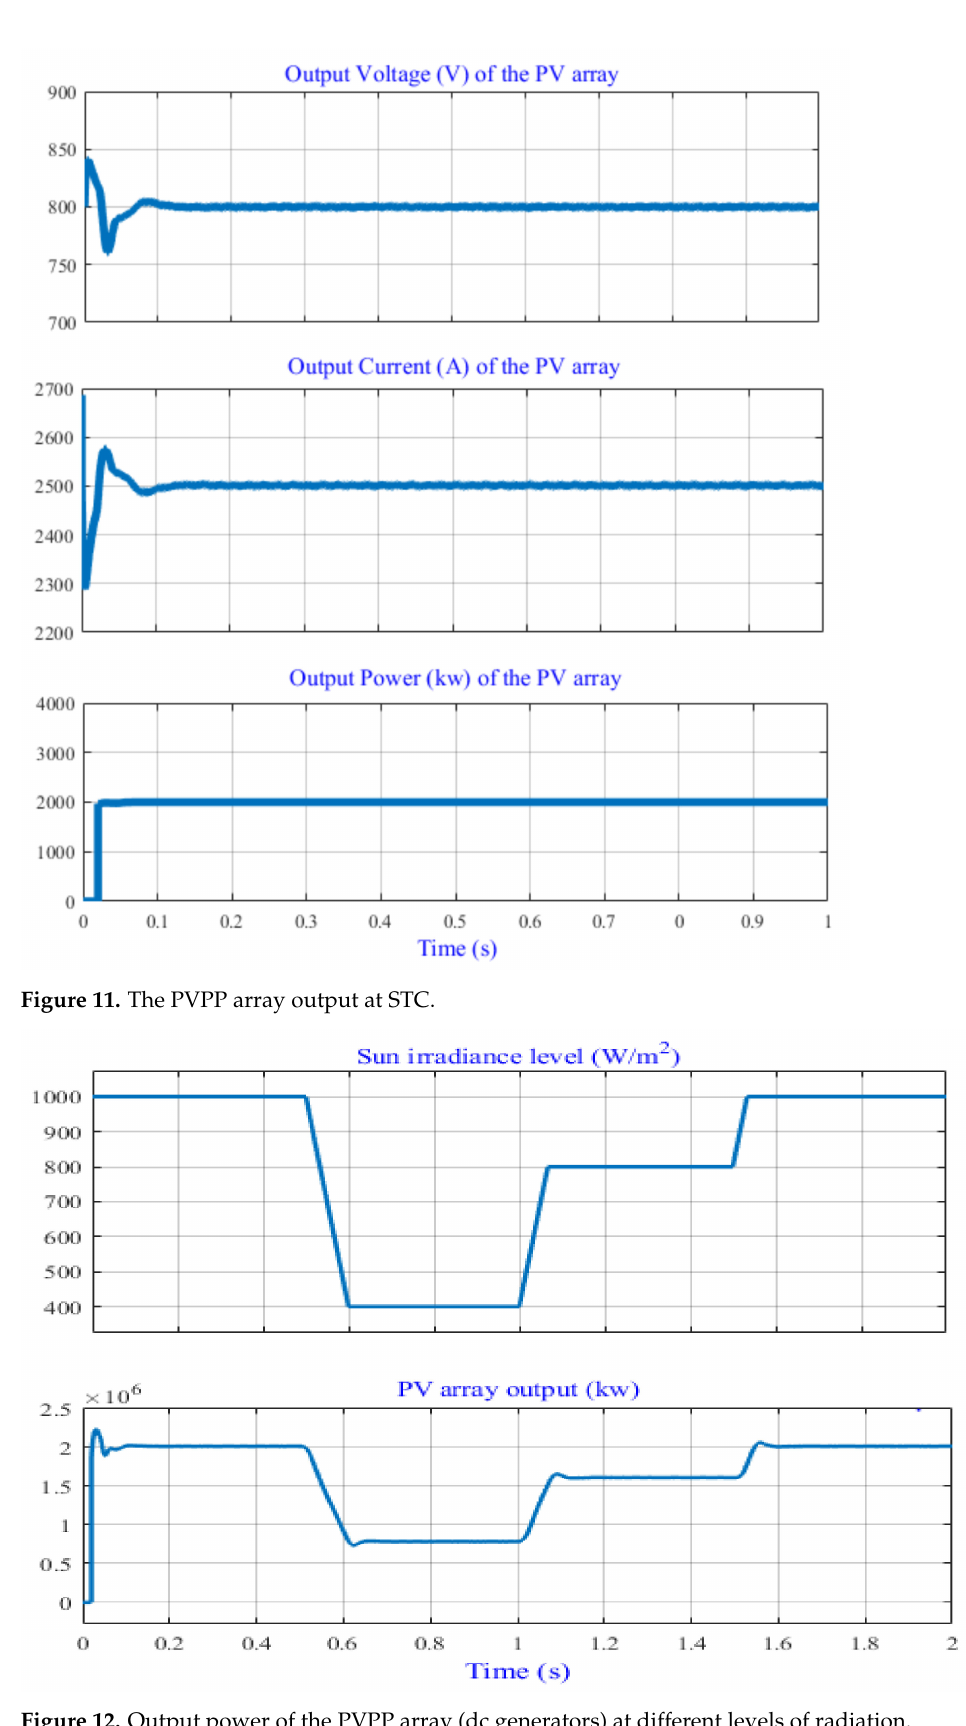
Figure 12. Output power of the PVPP array (dc generators) at different levels of